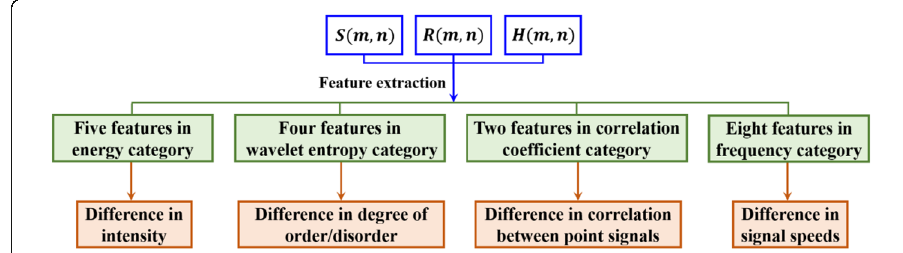
Fig. 6 Outline of the 19 features extracted from preprocessed radar signal S ( m , n ), respiration signal R ( m , n ), and the heartbeat signal H ( m , n ). Point signal represent the signal at one range point along the slow-time